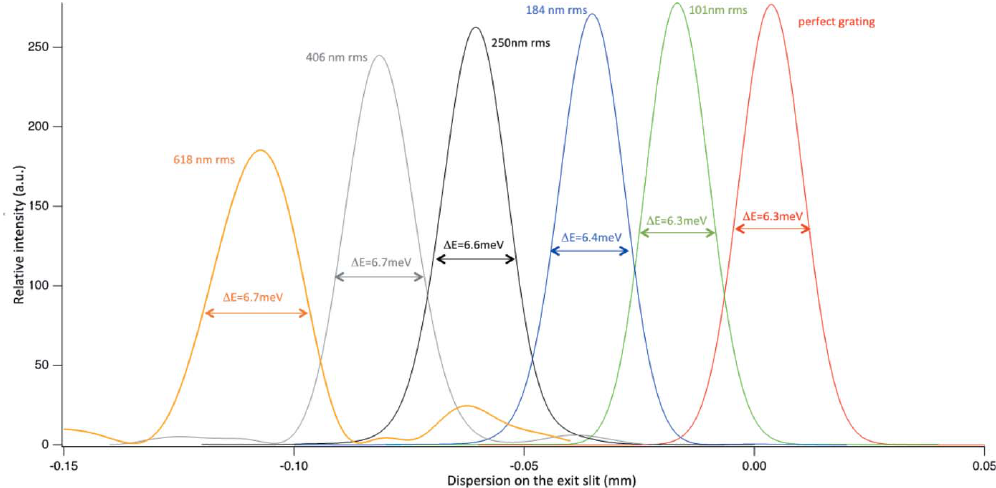
Figure 10 Results of wavefront propagation for the LRG at 80 eV for various r.m.s. groove-placing errors. Each curve is reported with its FWHM in meVand with the associated r.m.s. groove placing error. Line colors match text colors.